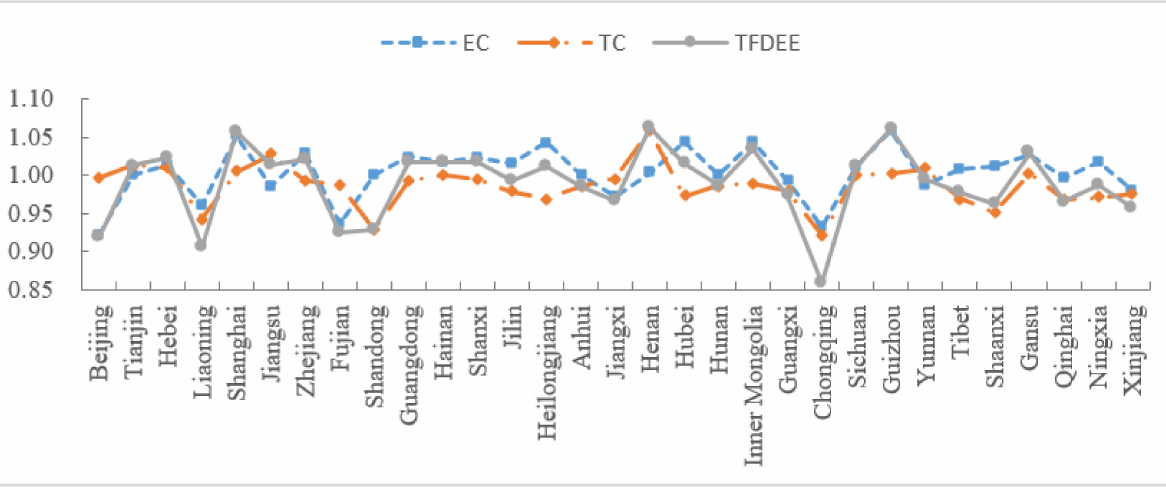
Figure 5. Average score of TFDEE and its decomposition index in China’s 31 provincial mining industries during